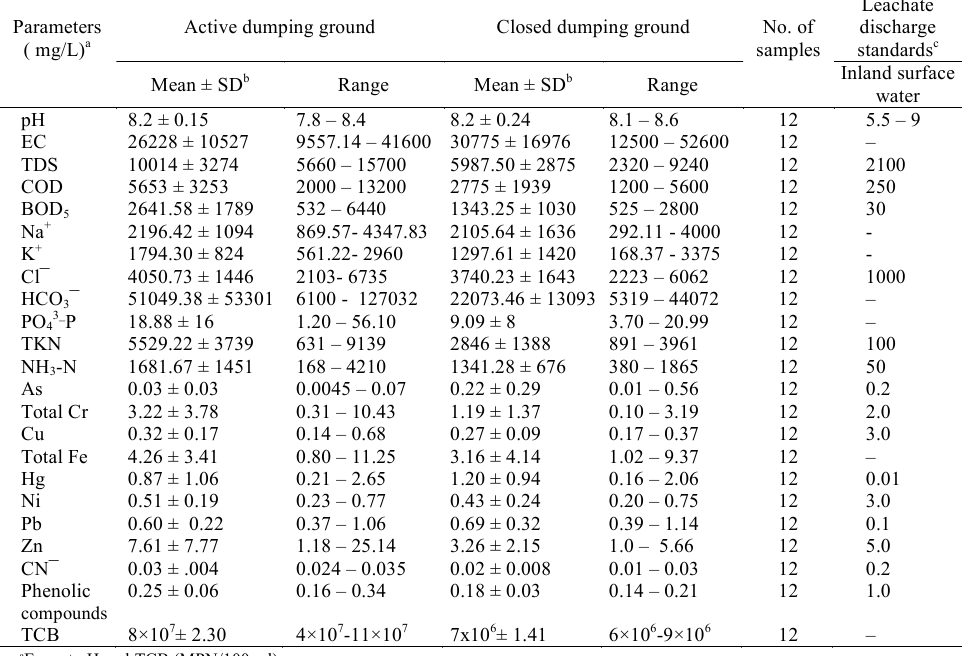
Table 1: Comparison of leachate characteristics of the active and closed dumping ground at Dhapa uncontrolled landfill site in Kolkata, India Parameters Active dumping ( mg/L) a